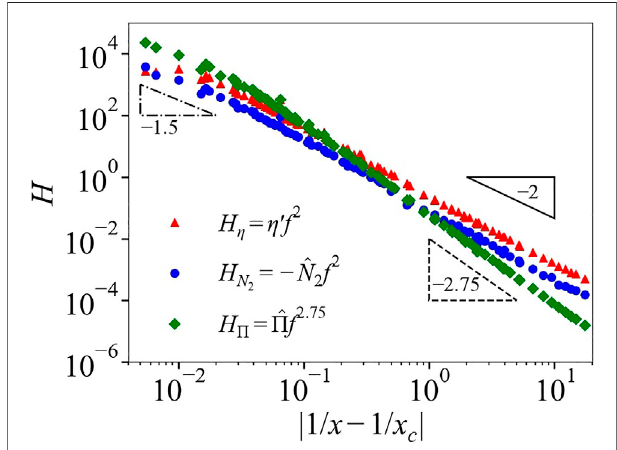
FIGURE 3 | Scaling functions H η (red triangles), H N (blue circles), and 2 − 1/ x | for simulated suspensions at δ = 1.4 H Π (green diamonds) versus |1/ x c and ζ = 0.50 for 0.52 ≤ ϕ ≤ 0.63 for exponential form f ( σ ) (cid:1) e ( σ */ σ ) . The black solid triangle shows the slope of − 2, the dashed black triangle of − 2.75, theblackdash-dottedtriangleof − 1.5.Datafor δ =1.4areadaptedfromSingh et al.